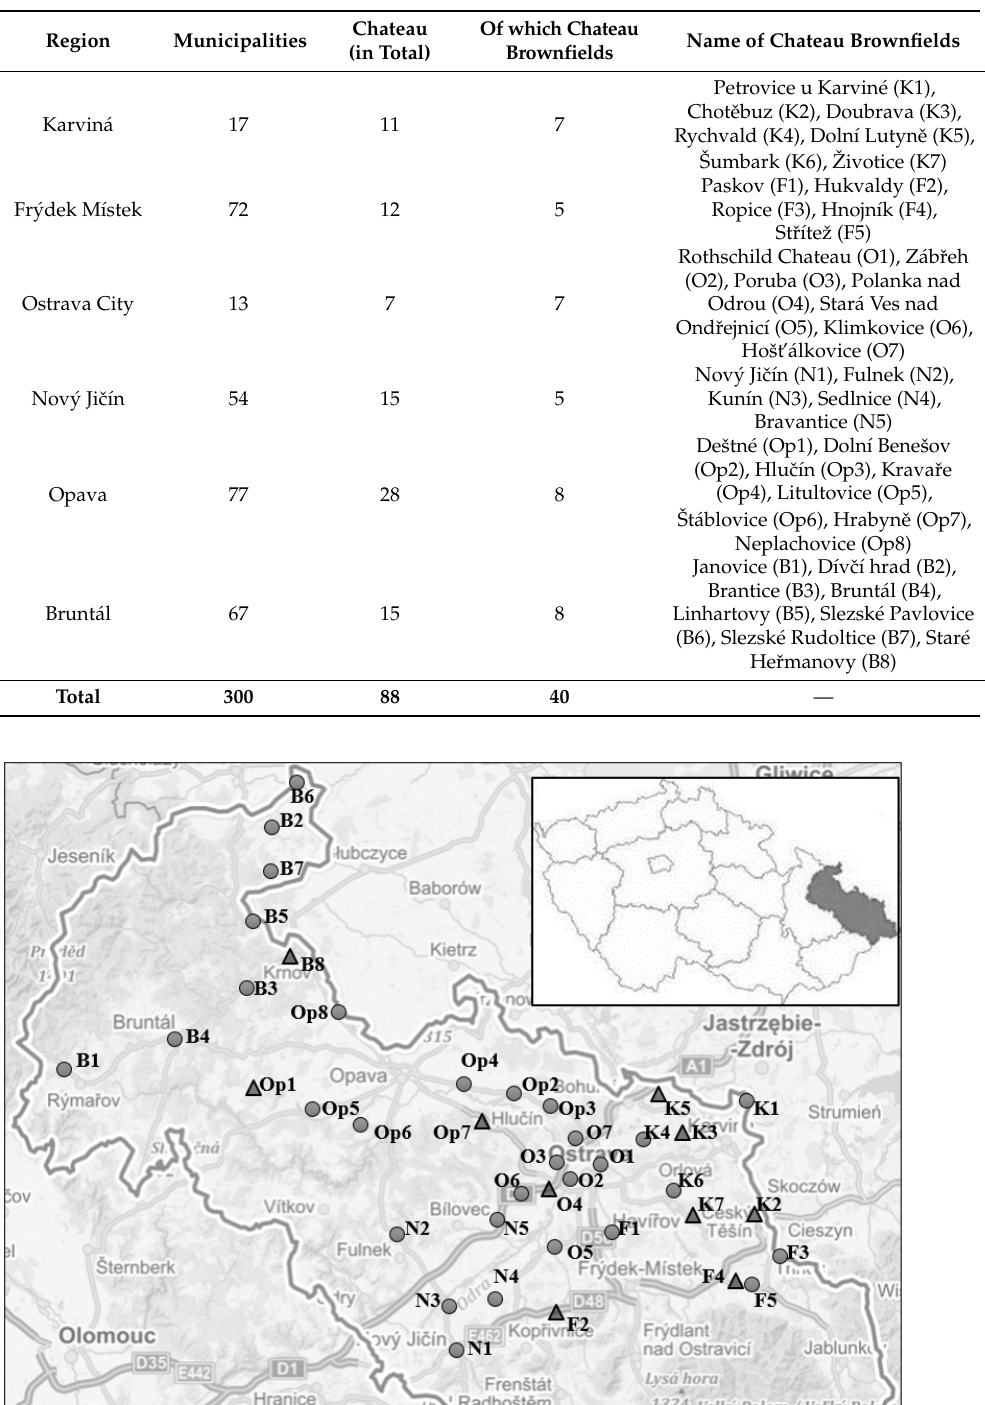
Table 1. Chateau and chateaux brownfield, Moravian-Silesian Region (2022).